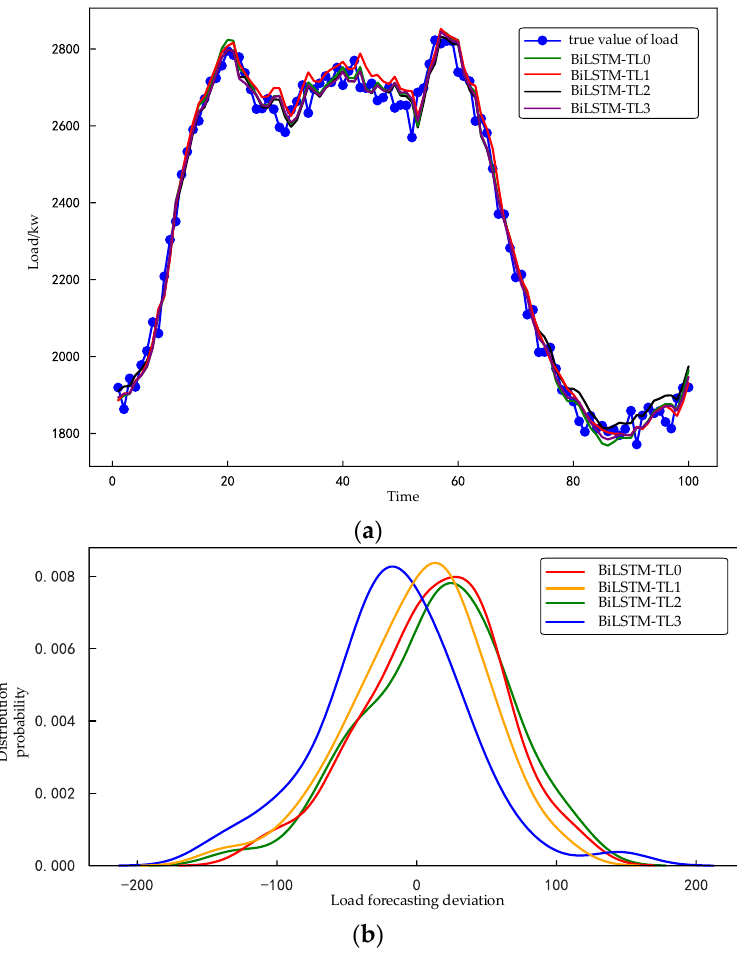
Figure 13. Comparison of prediction results of transfer learning model: ( a ) Comparison of prediction results of transfer learning model; ( b ) Prediction error distribution curve of transfer learning model.